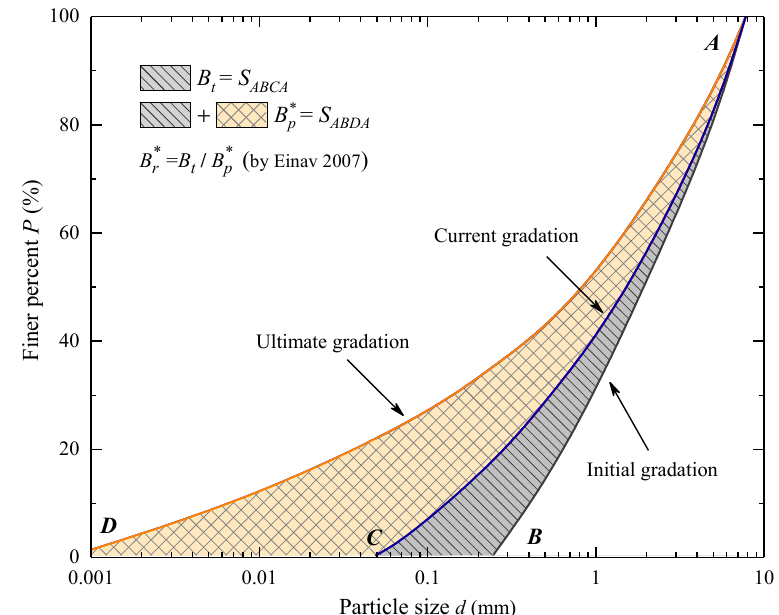
Figure 18. Calculated method of modified relative breakage index B r* .